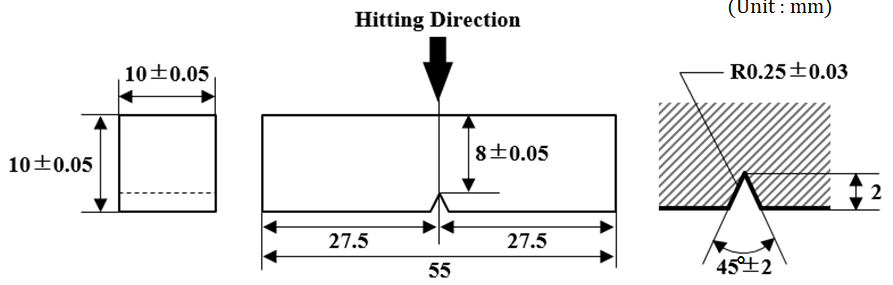
Figure 4. A schematic diagram of Charpy impact test.